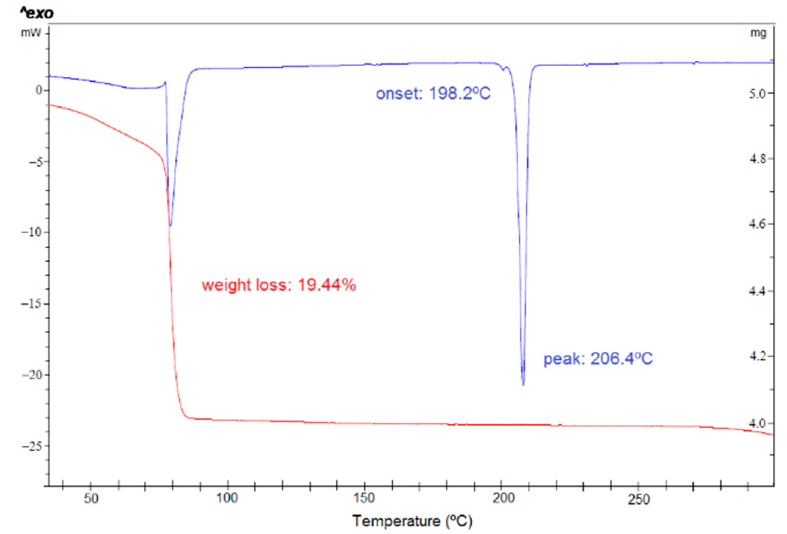
Figure 5. DSC (blue) and TGA (red) of form S CHCl3-H2O